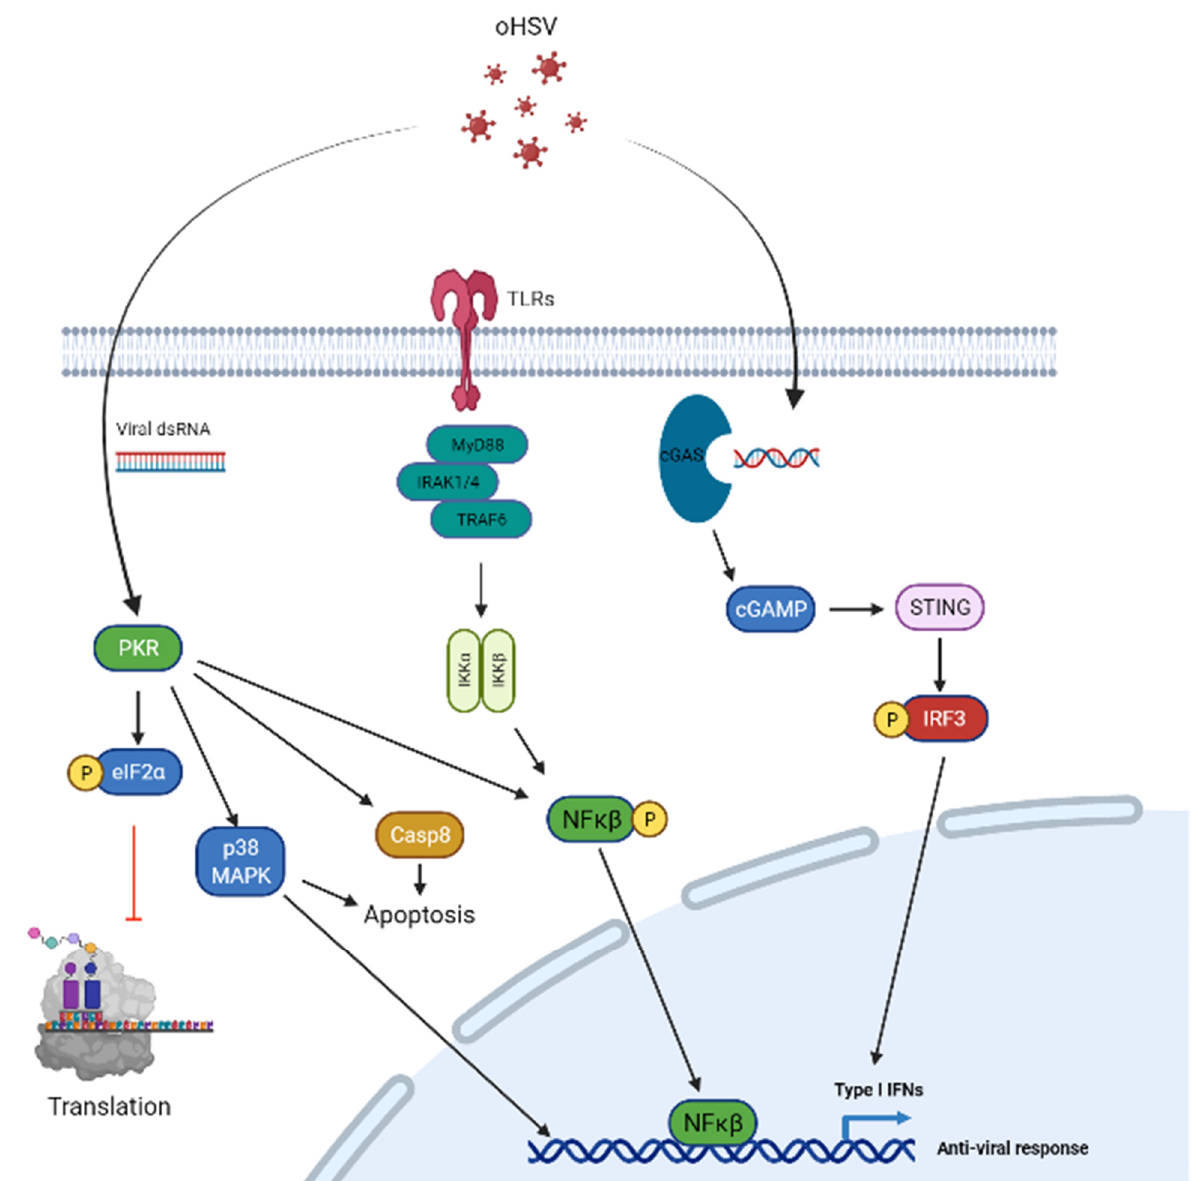
Figure 1. Signal transduction pathways in tumor cells and targeting for oHSV replication and spread. PKR signaling ( left ) confers a strong defense against viral infection which is activated by dsRNA from viral infection leading to auto-phosphorylation of PKR which phosphorylates eIF-2 α . Phosphorylated eIF-2 α leads to inhibition of cellular translation and prevents viral protein translation in the process. The PKR pathway is attenuated by oHSV via ICP34.5 which regulates PP1 and leads to PP1-mediated dephosphorylation of eIF-2 α . VHS is an oHSV tegument nuclease that is able to degrade viral RNA and thus avoid PKR signaling activation. Furthermore, US11 of oHSV directly interacts with PKR and prevents its auto-phosphorylation. Additionally, PKR regulates cellular apoptosis pathways via Caspase 8 and p38-MAPK signaling, and also contributes to anti-viral response via p38–MAPK and NF- κ B signaling pathways. Toll-like receptors ( middle ) are another pathway activated in infected cells and are able to detect viral nucleic acids. Upon entry of virus in the host cell, endosomes of infected cells detect viral nucleic acids leading to TLR activation. This leads to the recruitment of the adaptor protein, MyD88 and complexes with IRAK and TRAF6 ultimately leading to NK- κ B activation and an anti-viral response. cGAS-STING signaling ( right ) is activated through viral dsDNA and is detected by cell cyclic GMP–AMP synthase(cGAS). Activation of cGAS leads to synthesis of 2 ′ ,3 ′ -cGAMP and causes activation of its downstream target located on the cell’s endoplasmic reticulum, STING. Activation of STING leads to creation of autophagosomes and